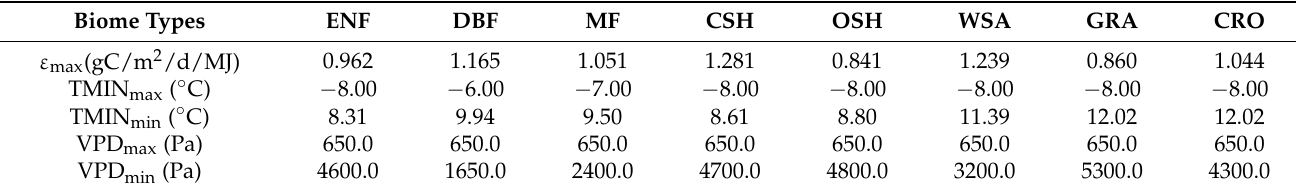
Table 3. Biome properties look-up table for the moderate resolution imaging spectroradiometer (MODIS) GPP algorithm